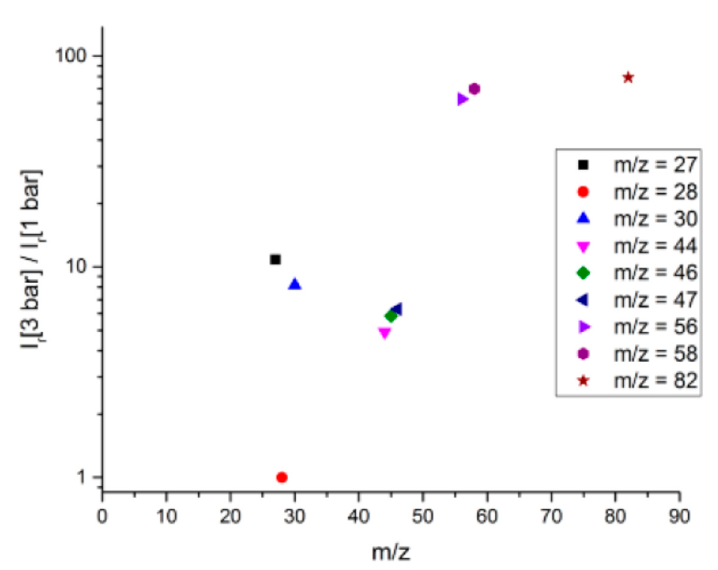
Figure 2. Quotient of the relative intensities at 3 bar and 1 bar of the emitted species during laser-induced pyrolysis of 90-10 propellant under nitrogen atmosphere.